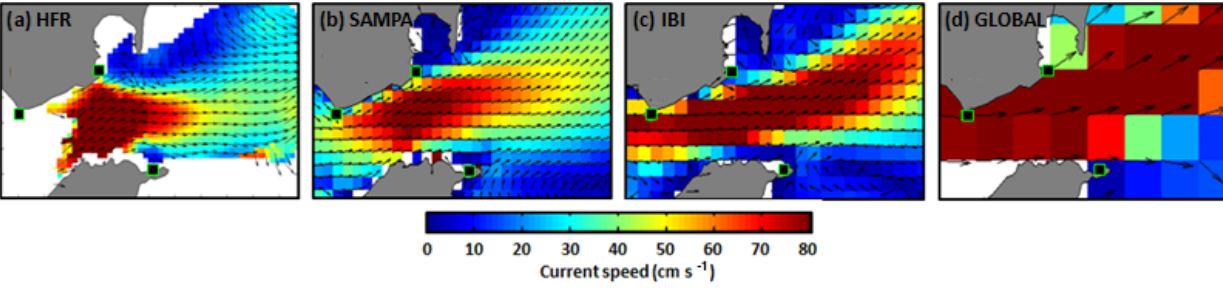
Figure 7. Annual mean circulation pattern in GIBST for 2017, derived from hourly estimations provided by (a) HFR, (b) SAMPA coastal model, (c) IBI regional model, and (d) GLOBAL model. For the sake of clarity, only one vector for every two was plotted in the HFR map.